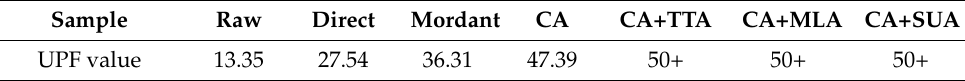
Figure 6. The antibacterial rates of the cotton fabrics (a, Raw; b, Direct; c, Mordant; d, CA; e, CA+TTA; f, CA+MLA; g, CA+SUA).